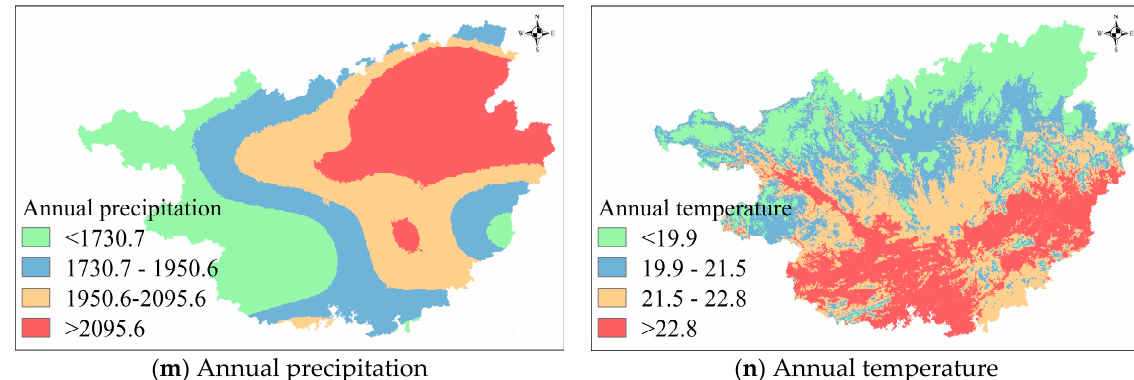
Figure 1. Spatial factor distribution of Guangxi province.